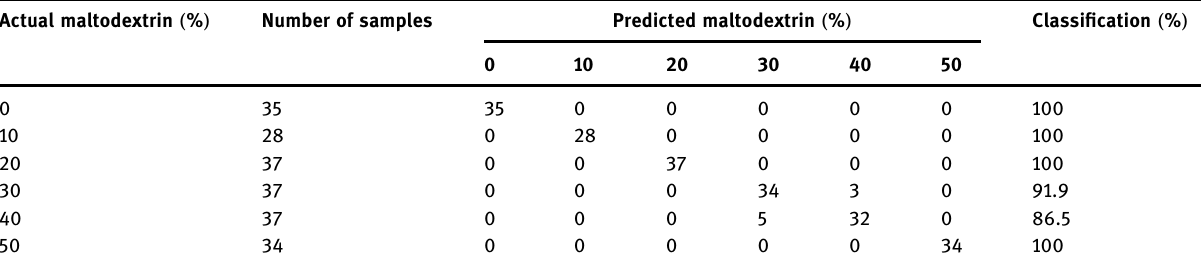
Table 2: PCA - DA classi fi cation model for pure and maltodextrin - added butter fl y - pea extract powder Actual maltodextrin ( %